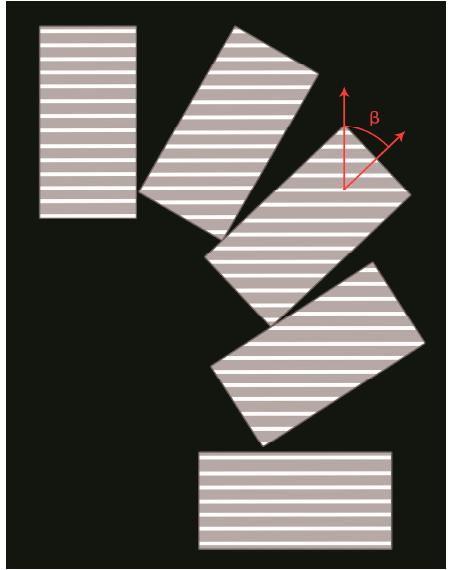
Figure 1. Schematic diagram of shale coring.